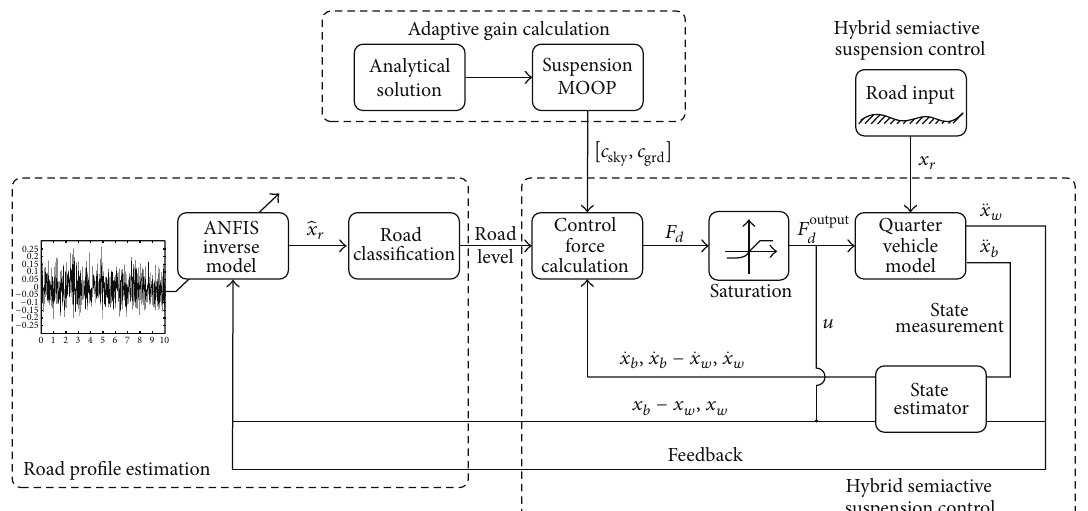
Figure 5: Structure of road estimation based hybrid control